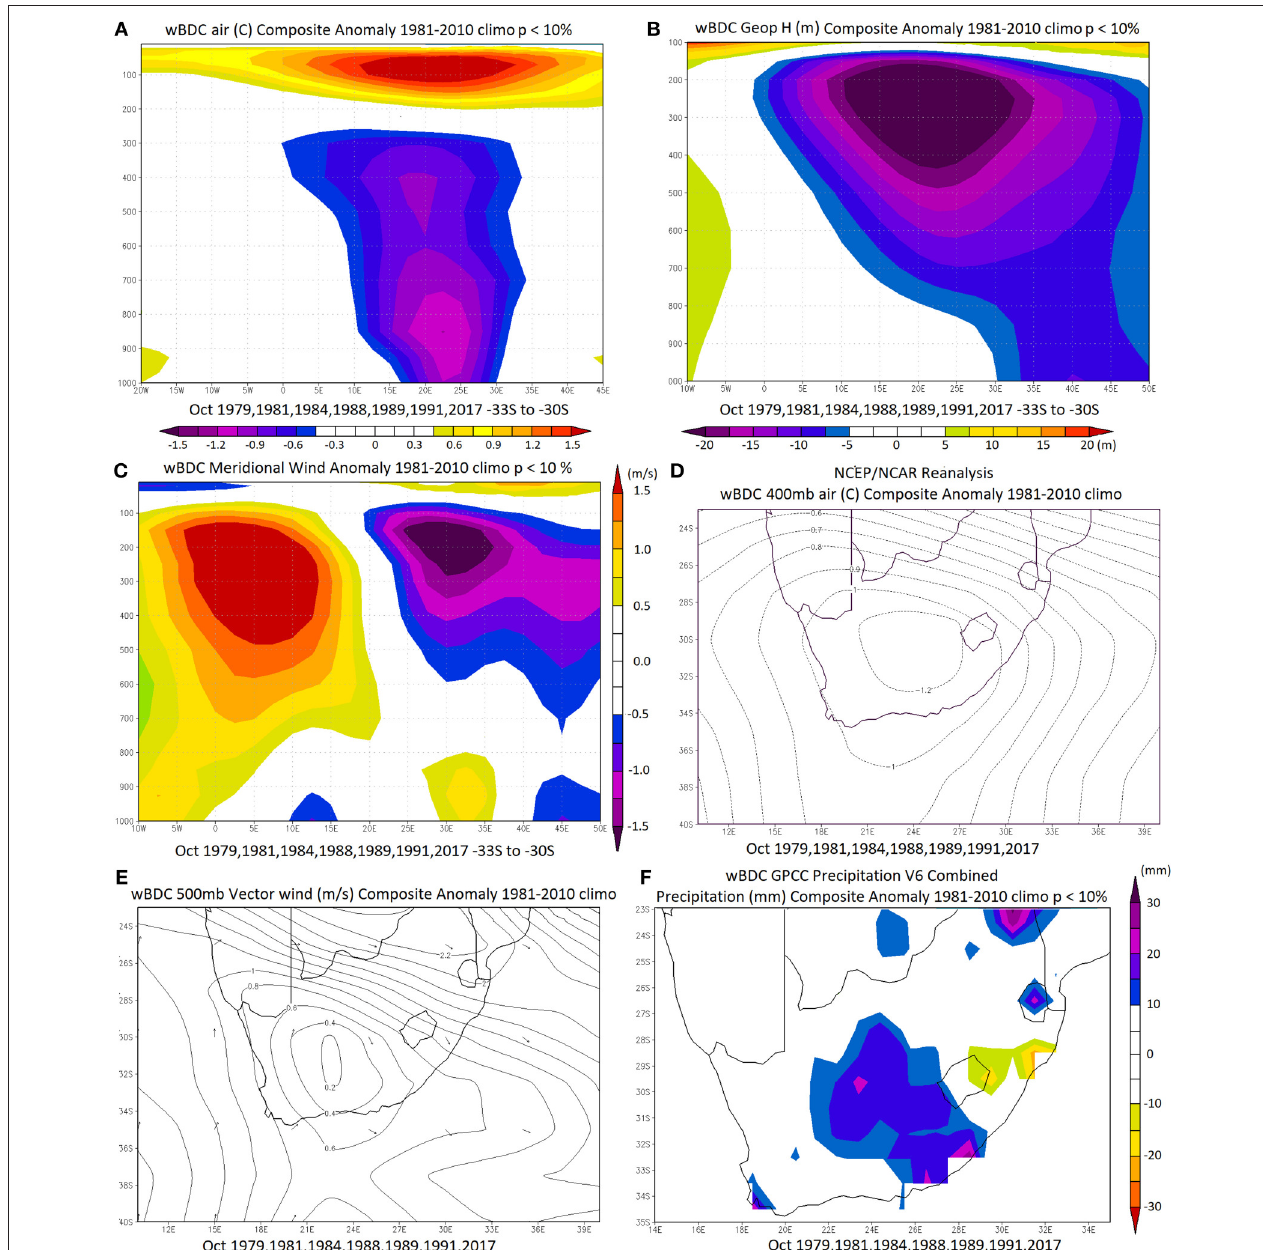
FIGURE 6 | Vertical slice of the (A) air temperature ( ◦ C), (B) geopotential height (m) and (C) the meridional wind (m/s) pattern for the wBDC composite anomalies averaged over (A) 21 ◦ E to 25 ◦ E and extending from 40 ◦ S to 20 ◦ N, (B) 33 ◦ S to 30 ◦ S and covering 10 ◦ W to 45 ◦ E. Composites but for (D) air temperature anomalies ( ◦ C) for the 400mb level, (E) same as for (D) but for the 500mb wind (m/s) level and (F) land only rainfall anomalies (mm) with the region covered indicated in each panel. The anomalies are with respect to the 1981–2010 climatology. Shaded regions are significant above the 90% confidence level. Years for the composites are indicated in the